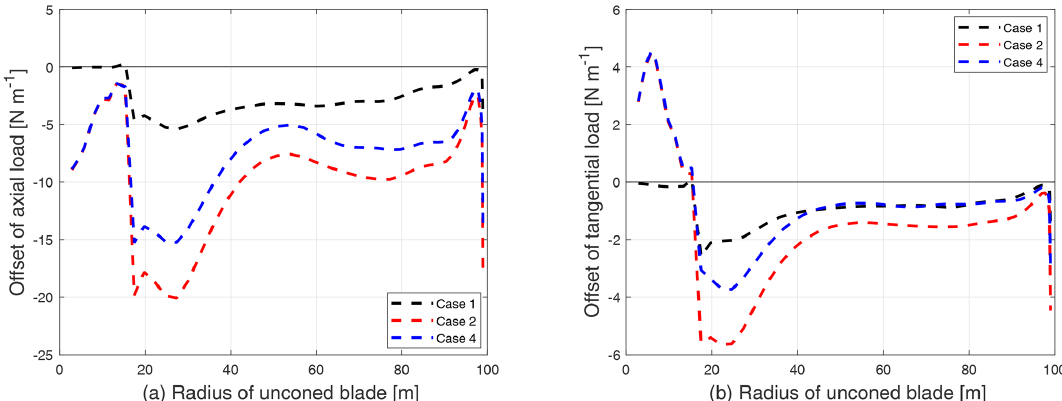
Figure 8. Comparison of the difference in axial load (a) and tangential load (b) of the upwind dihedral blade W-1 with 15 ◦ of additional upwind coning calculated using the three different methods compared to the intuitive correct method (Case 3) from the two-point LL